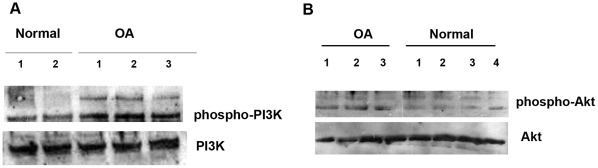
Phospho-PI3K and phospho-Akt expression in normal and osteoarthritic chondrocytes.(A) A representative western blot showing phospho-PI3K protein expression level in normal and osteoarthritic chondrocytes. Total PI3K expression level is shown in the lower panel. (B) A representative western blot showing phospho-Akt protein expression level in normal and osteoarthritic chondrocytes. Total Akt expression level is shown in the lower panel.